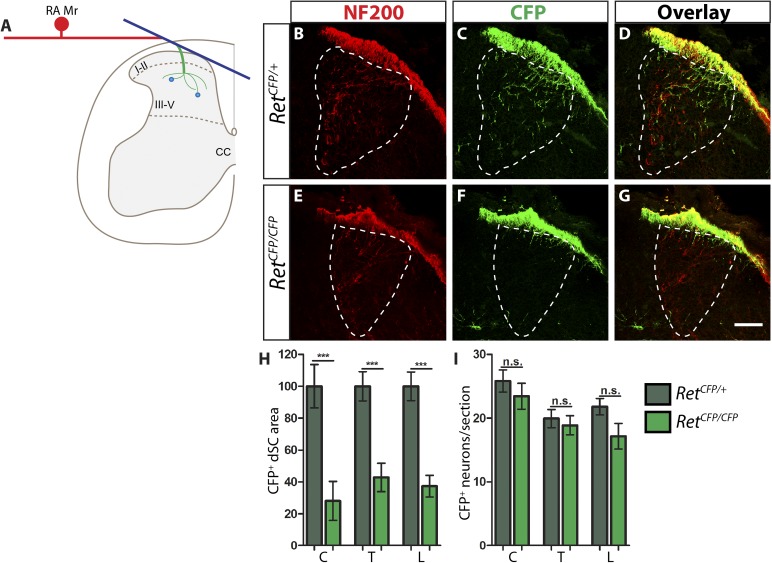
Ret is required for the growth of RA mechanosensory third order central projections at E13.5.(A) Schematic of development of RA mechanosensory central projections. RA mechanoreceptors grow central and peripheral axons soon after neurogenesis, generating first order branches (red color). Upon reaching the dSC, the central axons bifurcate and send second order longitudinal branches rostrally and caudally (blue color). Around E13.5, third order interstitial projections (green color) from the longitudinal branches innervate layers III–V of the dSC and develop complex branching patterns. Synaptic connections between mechanoreceptors and dSC neurons (light blue dots) develop from E18.5. (B–G) Anti-NF200 and anti-GFP immunostaining of E13.5 RetCFP/+ (B–D) and RetCFP/CFP (E–G) SC. The dSC innervations of RA mechanosensory fibers are outlined by white dotted line. (H) Quantification of CFP+ pixel number in the dSC, which is displayed as a percentage of pixel number relative to control. There is a significant decrease in CFP+ axons innervating the SC in Ret mutants, suggesting that the initial growth of RA mechanosensory third order projections depends on RET signaling. (I) Quantification of the number of CFP+ neurons per DRG section. There is no significant change in the number of CFP+ neurons per DRG section, suggesting that there is no cell death or downregualtion of CFP expression in E13.5 Ret null RA mechanoreceptors. Scale bar = 50 μm. C = Cervical, T = Thoracic, L = Lumbar. Error bars represent SEM. n.s. = p > 0.05, *** = p < 0.001. Source data are provided in Figure 1—source data 2.